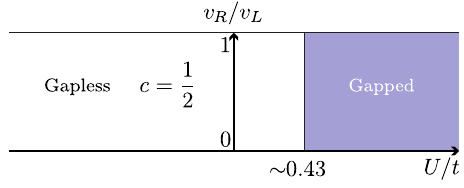
FIG. 6. Schematic phase diagram of Eq. (20) as a function of U=t and velocity anisotropy induced by t 0 . Here, v and v , R L respectively, denote the velocities for right- and left-moving Majorana fermions at U ¼ 0 ; Eq. (23) specifies their ratio. We ≤ 1 for simplicity, though clearly the same =v assume 0 < v R L ↔ v physics arises when v . Crucially, the phase boundary R L separating the critical c ¼ 1 = 2 state and the spontaneously — as =v dimerized gapped phase depends very weakly on v R L we find in our DMRG calculations. This observation suggests that unequal Majorana-fermion velocities, which would be expected for right and left movers of distinct physical origin (see, e.g., Fig. 7), do not obstruct the formation of a gapped